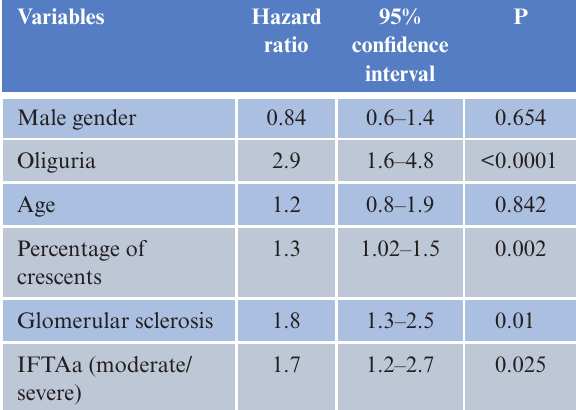
Table 6: Multivariate analysis of predictors of poor